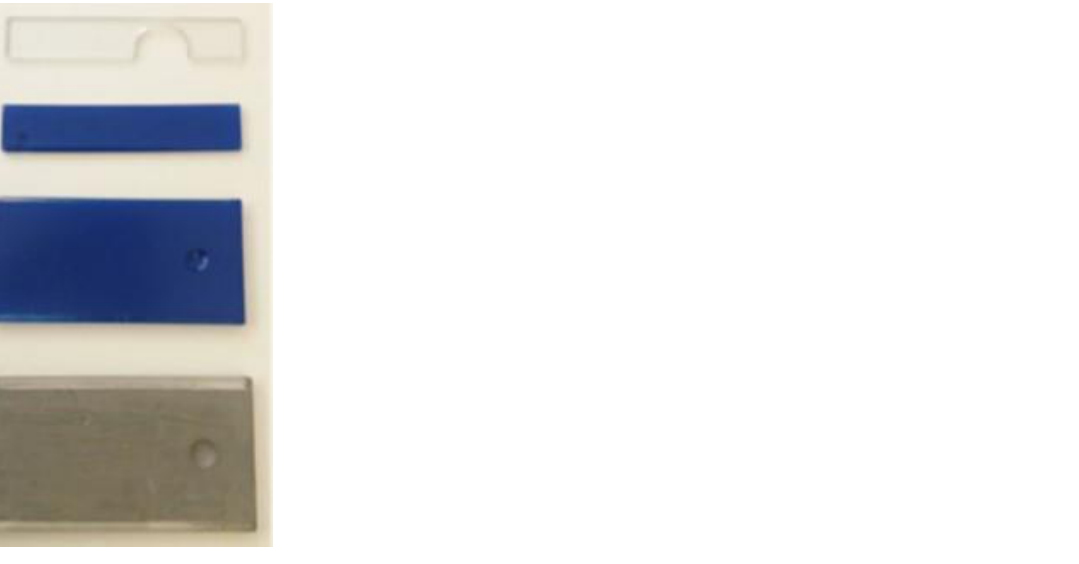
Note . From top to bottom: the transparent side piece used to stop the monkeys reaching in through the side of the box; the blue side blocker piece; the blue trap piece; and the grey shelf